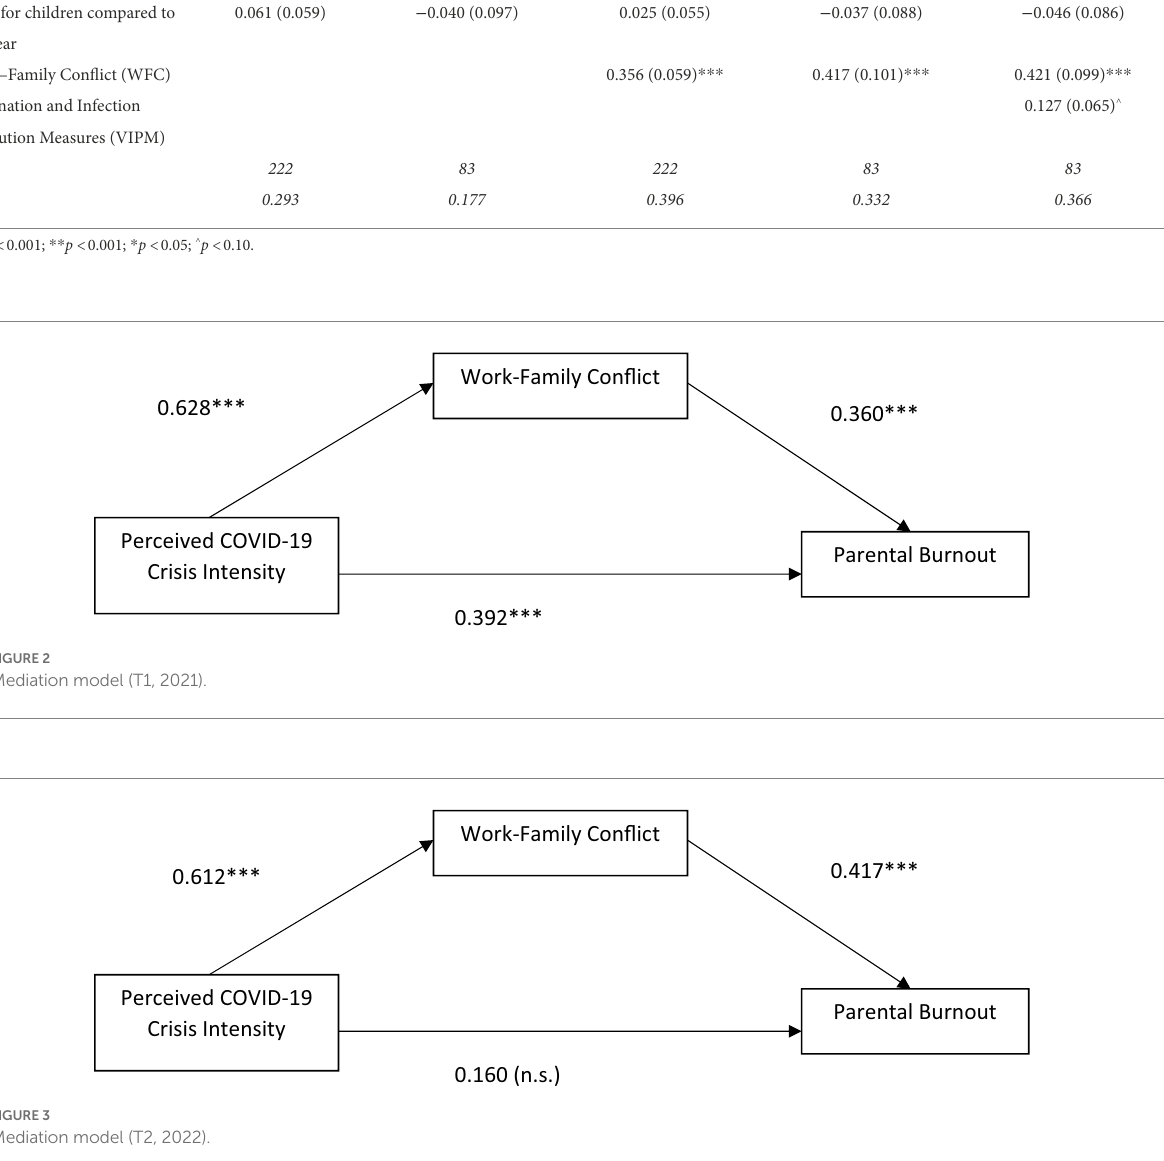
FIGURE 3 Mediation model (T2,